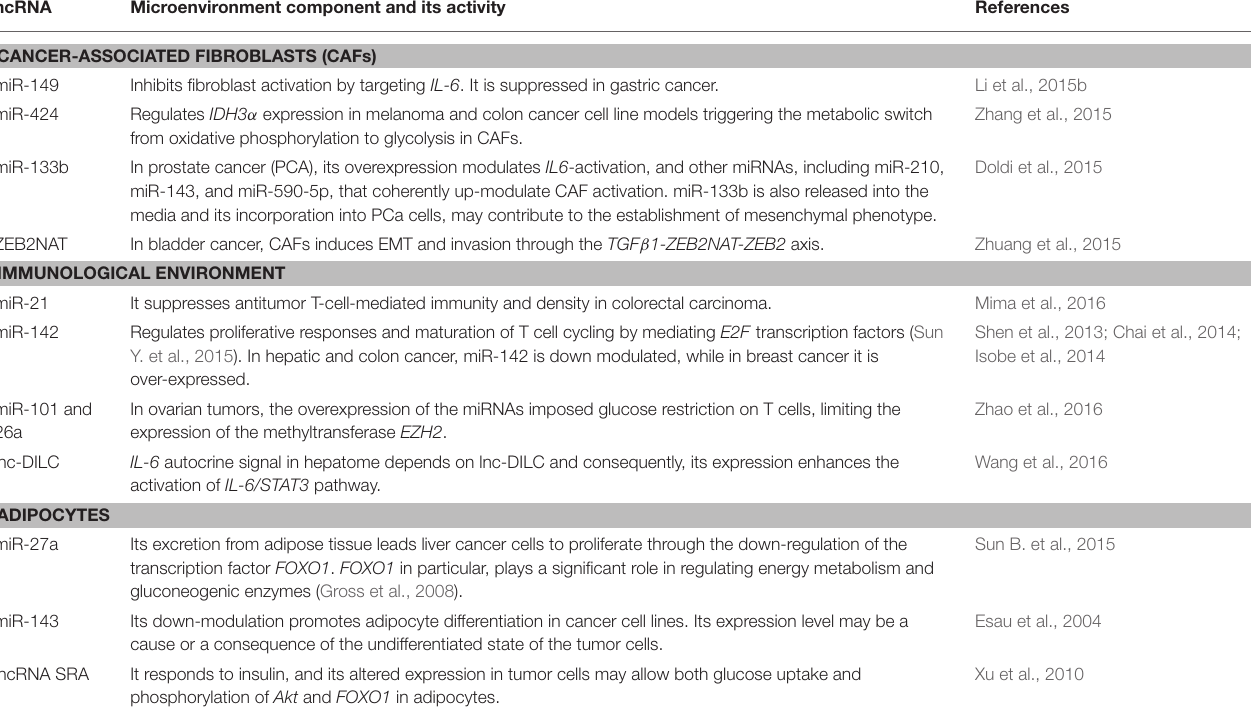
TABLE 2 | ncRNAs and tumor microenvironment.